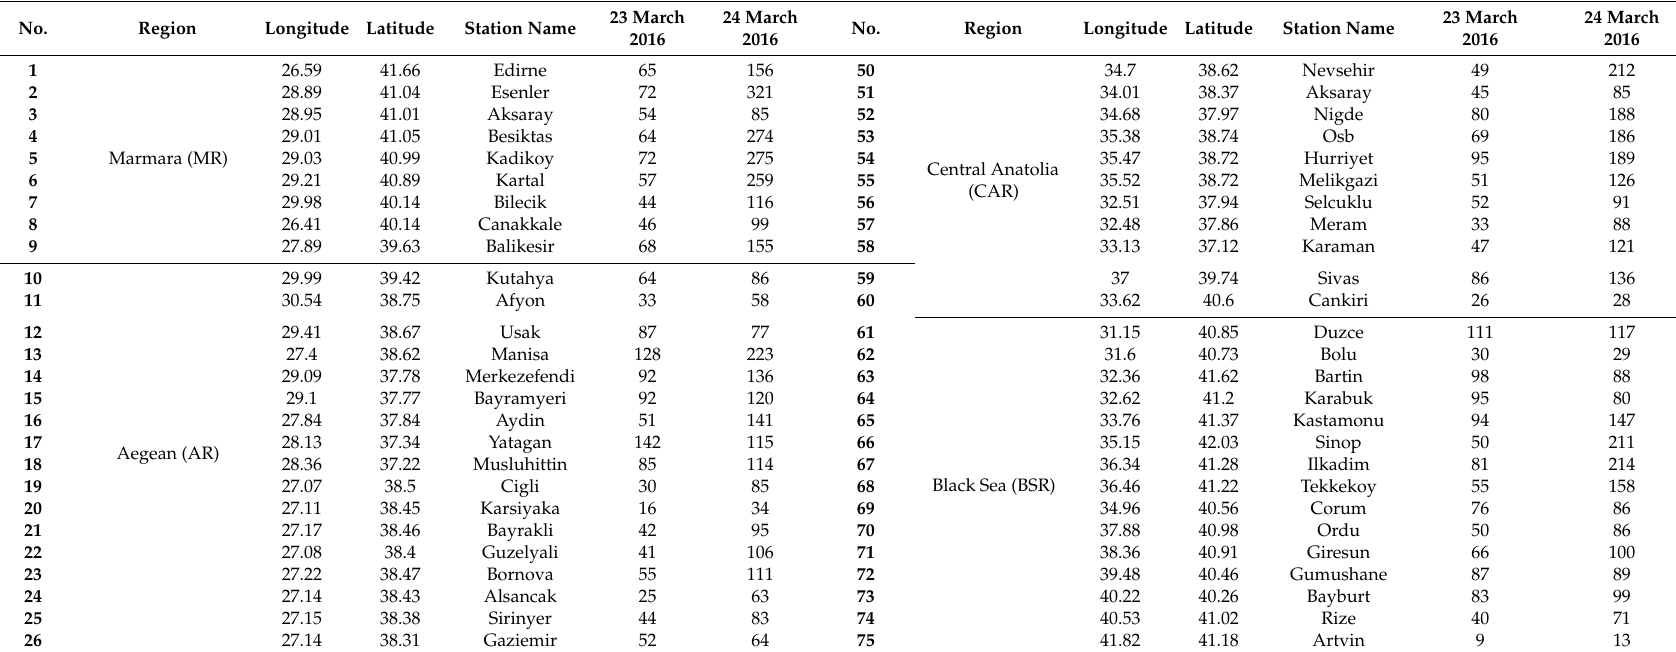
Table 1. Geographic coordinates of the 97 air quality stations and their measured daily PM 10 values ( µ g · m − 3 ) during dust storm days.